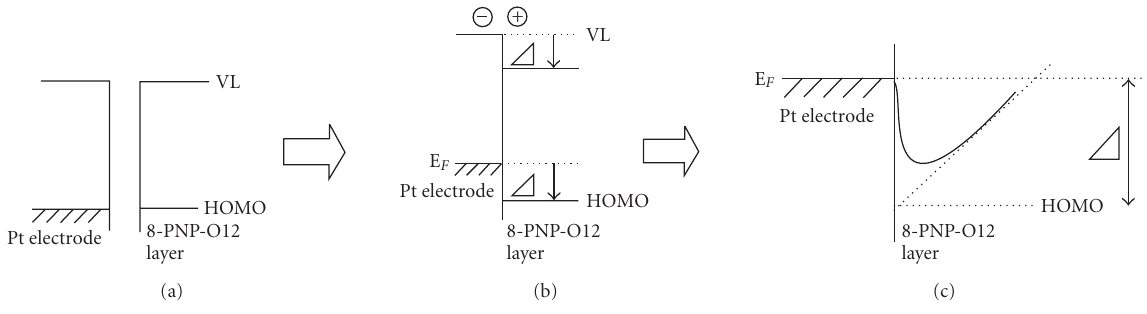
Figure 11: Electronic structure of the interface between a platinum electrode and 8-PNP-O12 layer before and after they come in contact with each other in the absence of applied voltage ((a) and (b), resp.) and in the presence of applied voltage (c), where VL is the vacuum